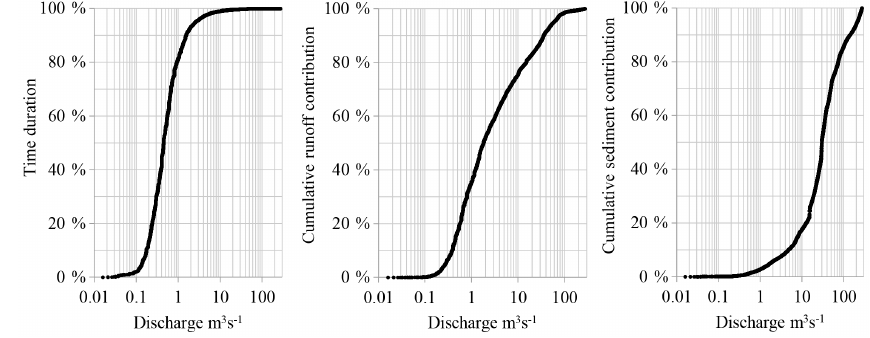
Figure 3. Cumulative frequency, water and sediment inputs assigned to ordinal discharge in the Wadi Sebdou